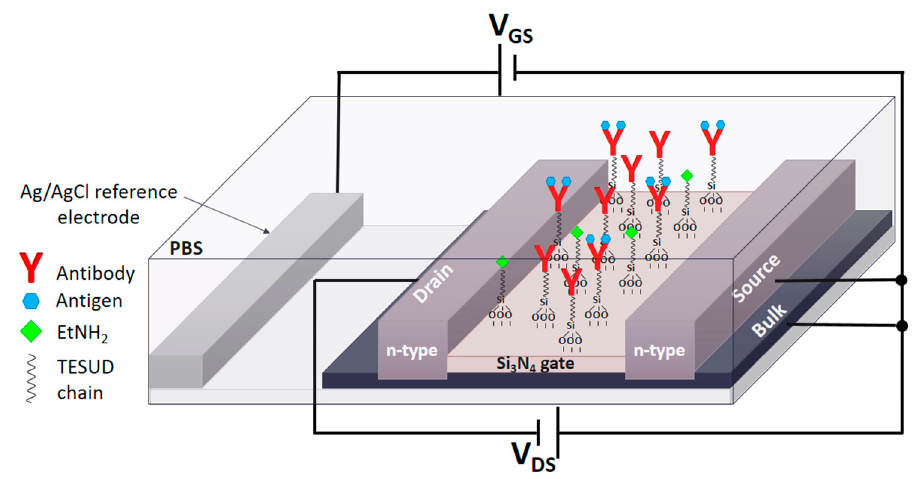
Figure 3. Schematic illustration of ImmunoFET device operating system with immobilized antibodies for antigen detection.